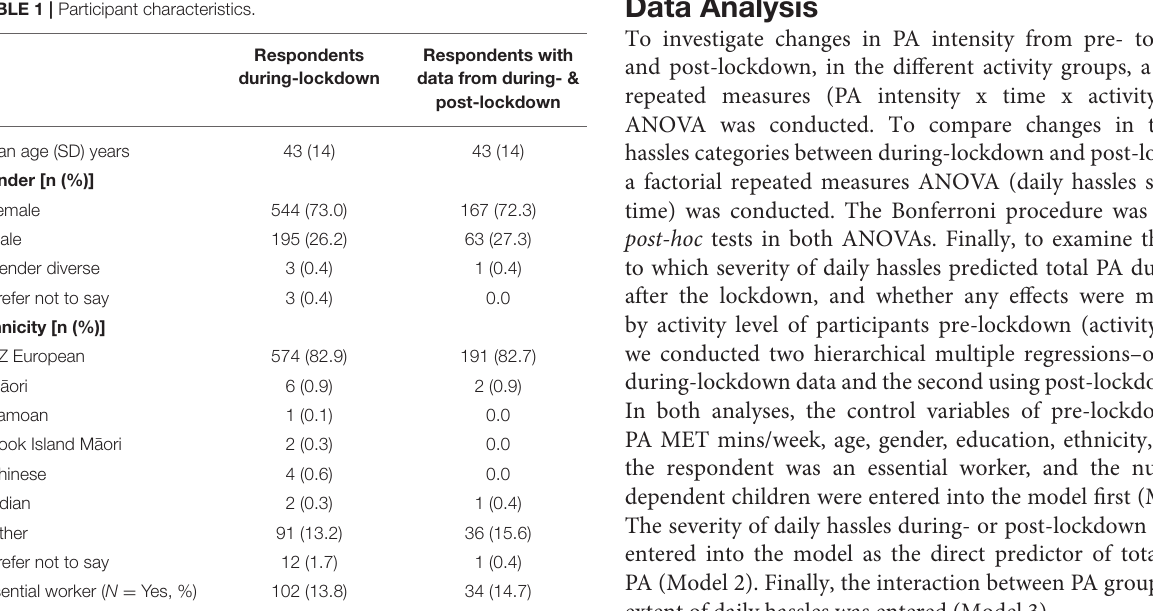
TABLE 1 | Participant